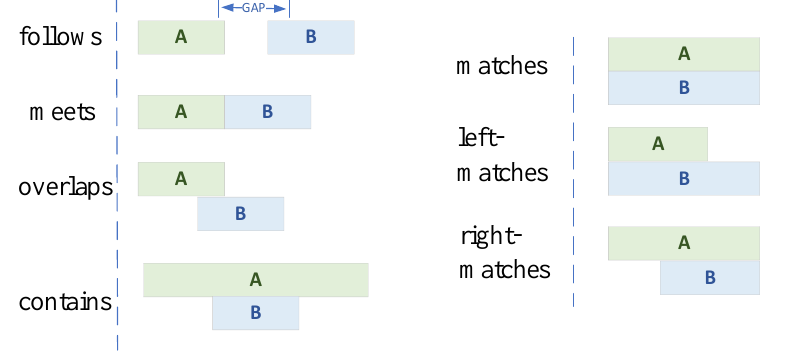
Figure 6. Five types of task relationships.